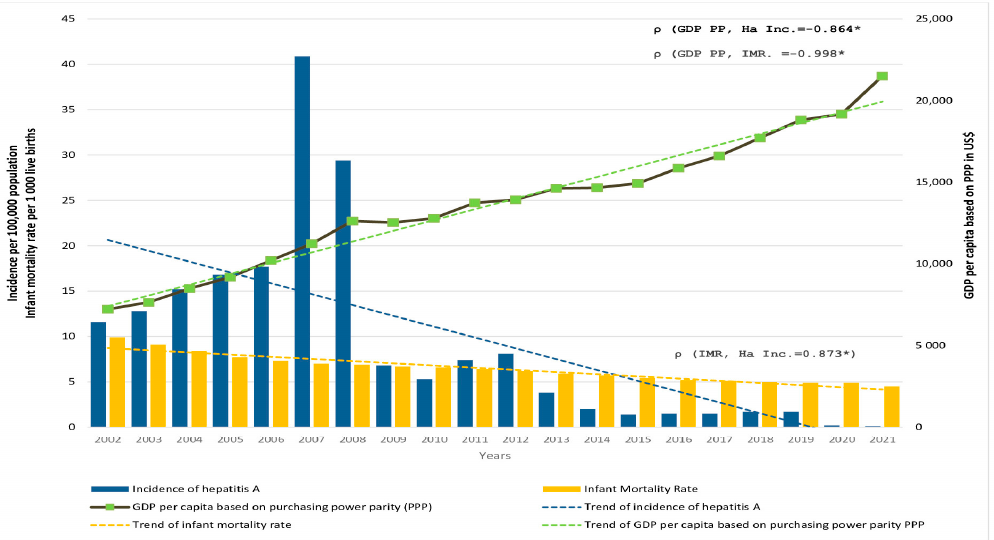
Figure 4. Incidence of hepatitis A (HA Inc.) per 100,000 population (blue bars, left axis), infant mortality rate (IMR) per 1000 live births (yellow bars, left axis), and GDP per capita based on purchasing power parity (GDP PPP) in US dollars (solid black line, right axis) in Serbia in the period 2002 to 2021. The corresponding trendlines are also shown. * p < 0.001.